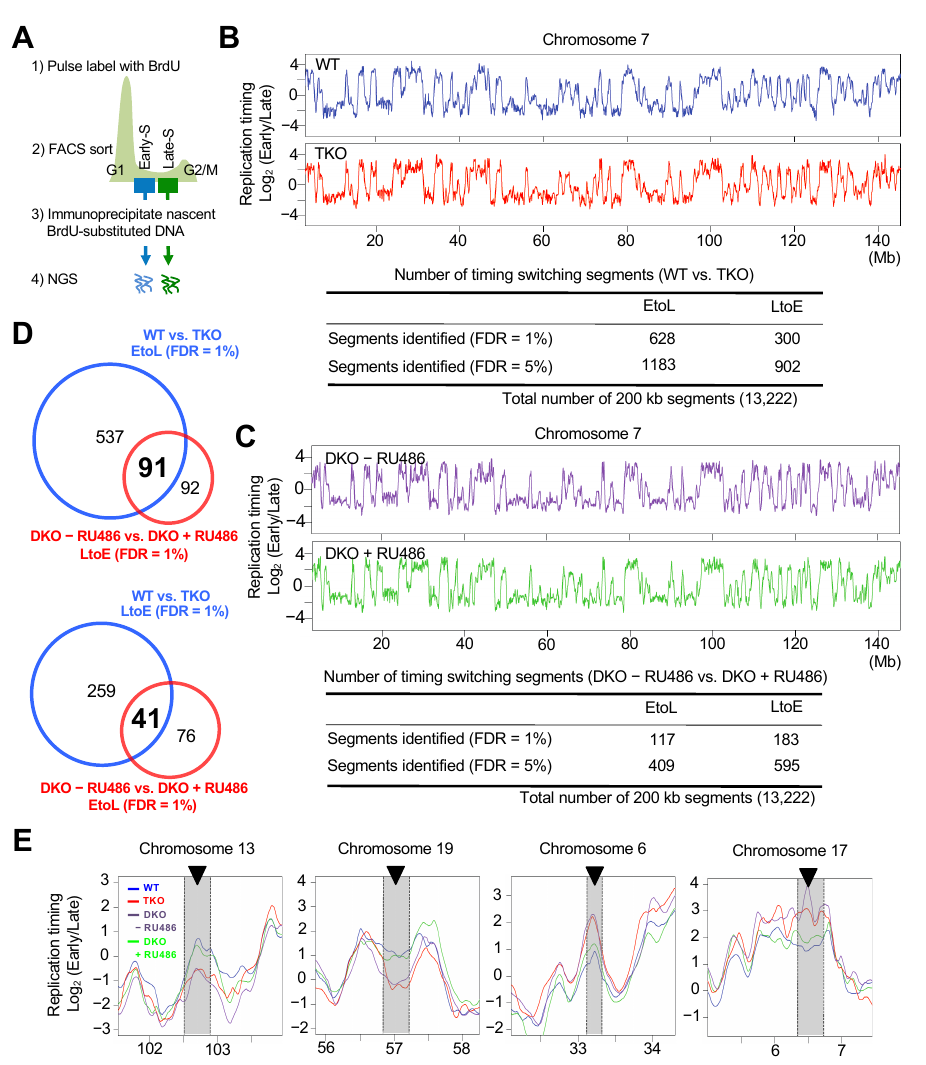
Figure 2. Genome-wide replication timing analysis identified a subset of chromosomal regions sensitive to Dnmt loss. ( A ) Flowchart of genome-wide replication timing analysis. BrdU-substituted DNA from early and late S phase cells was differentially labeled and sequenced by next generation sequencing. ( B ) Replication timing profiles of control wild-type and TKO ES cells for chromosome 7. The sequence read count ratio for the early and late cells (Log 2 early/late) for each 5-kb genomic bin was plotted against the chromosomal position (top panel). The LOESS-smoothed plots for the average of two biological replicate experiments are shown. The significant EtoL and LtoE switching segments in the TKO ES cells are indicated in the table (bottom panel). Replication timing data were averaged into 200-kb windows and statistical significance was calculated between the control wild-type and TKO ES cells, as described in the Methods. ( C ) Replication timing profiles for chromosome 7 of the Dnmt3a − / − Dnmt3b − / − double-knockout ES cells with and without Dnmt3a2 induction (DKO + RU486 vs. DKO − RU486; top panel). The significant early-to-late (EtoL) and late-to-early (LtoE) switching segments upon Dnmt3a2 induction in the DKO ES cells are indicated in the table (bottom panel). ( D ) The overlap between genomic segments that underwent replication timing switching is shown as a Venn diagram (using the FDR = 1% data from Figure 2B,C). ( E ) Expanded plots of representative regions that underwent replication timing switches in Dnmt -mutant ES